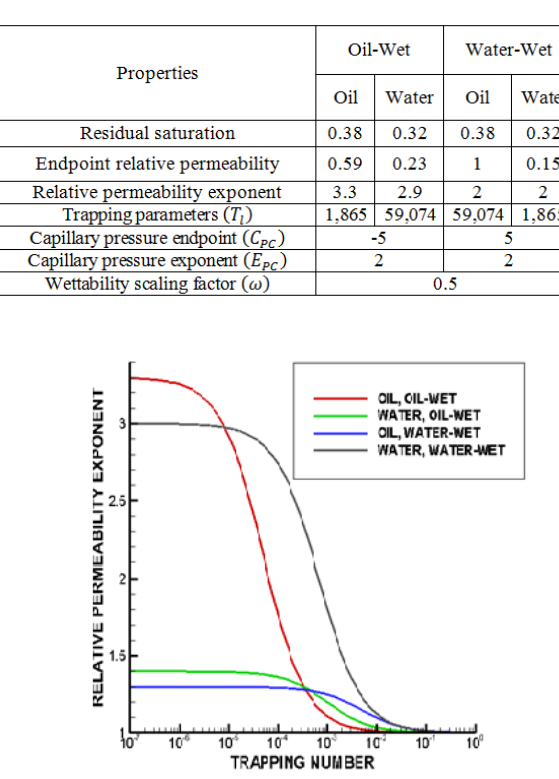
Figure 3: Relative permeability exponents varying with trapping number